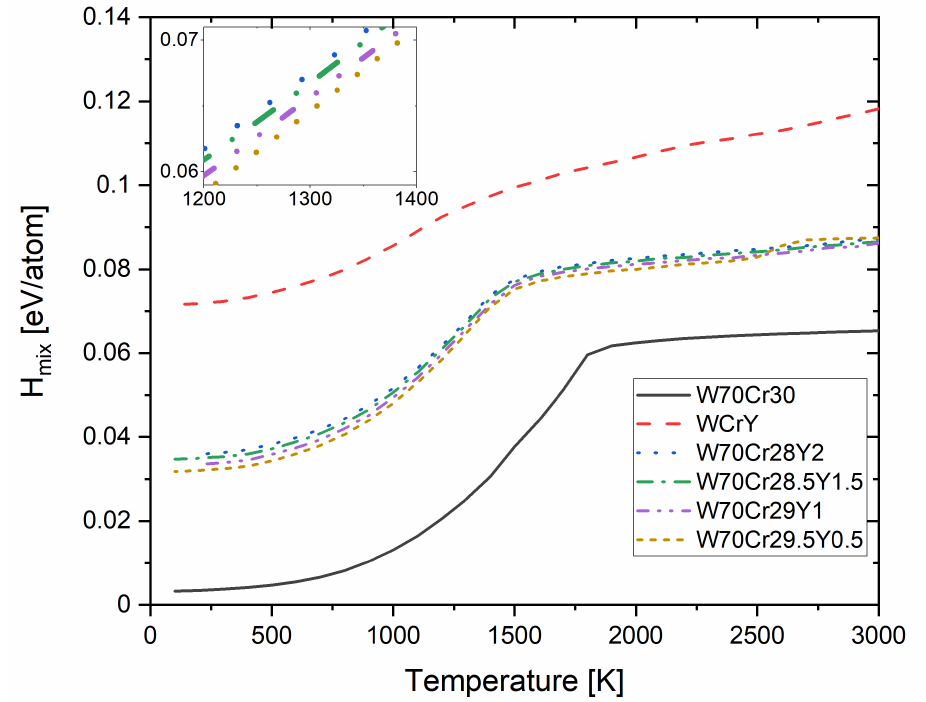
Figure 5. Enthalpy of mixing as a function of temperature for W 70 Cr 30 , equiatomic WCrY, and deriva- tive W 70 Cr ( 30 − x ) Y x , for x = ( 0.5;1;1.5;2 ) alloys. The inset is a zoomed area of the presented